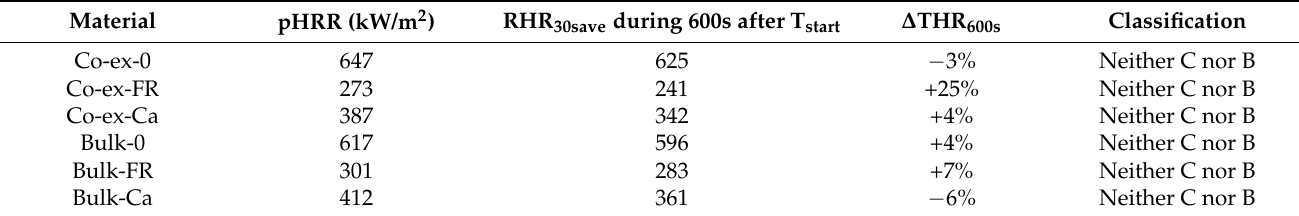
Figure 23. Total heat release for bulk-protected formulations before and after weathering. 0: without any filler; FR: with FR CROS 490; and Ca: with calcium carbonate. Table 13. Results for RHR 30save and for the increase of the total heat release (THR 600s ) for solid profiles after weathering for 28 days. Classification of the results according to ETAG 028 (2012). 0: without any filler; FR: with FR CROS 490; Ca: with calcium